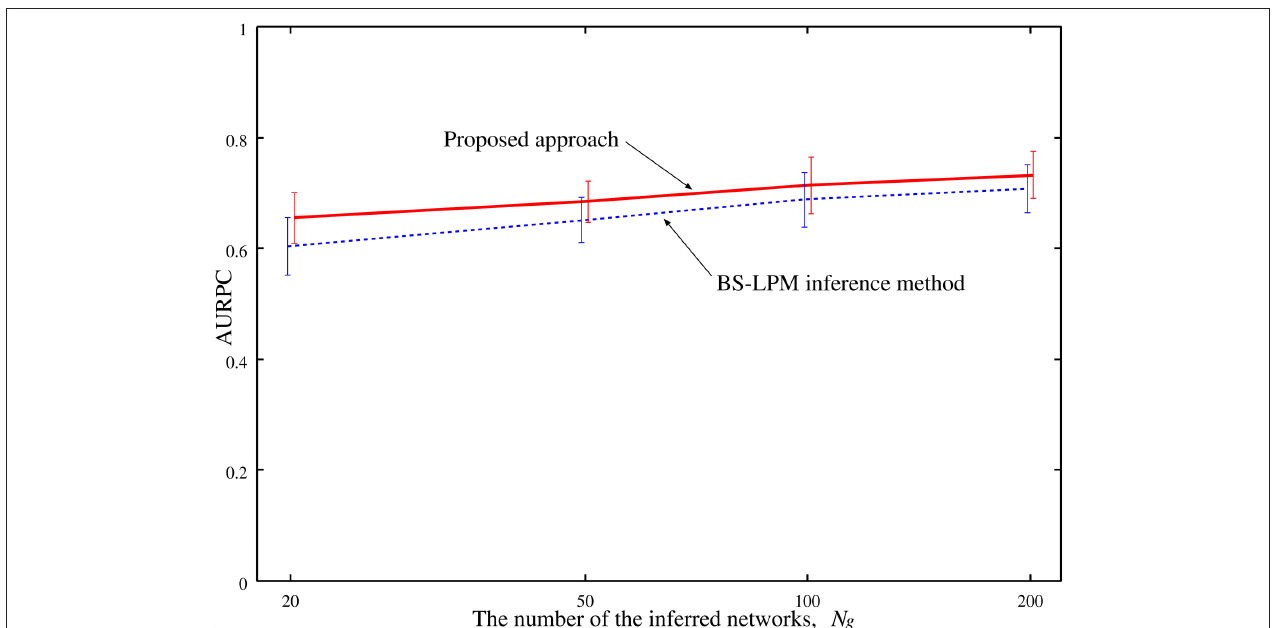
FIGURE 5 | The averaged AURPCs of the proposed approach (solid line) and the BS-LPM inference method (dotted line) plotted against the number of the inferred networks, N g .